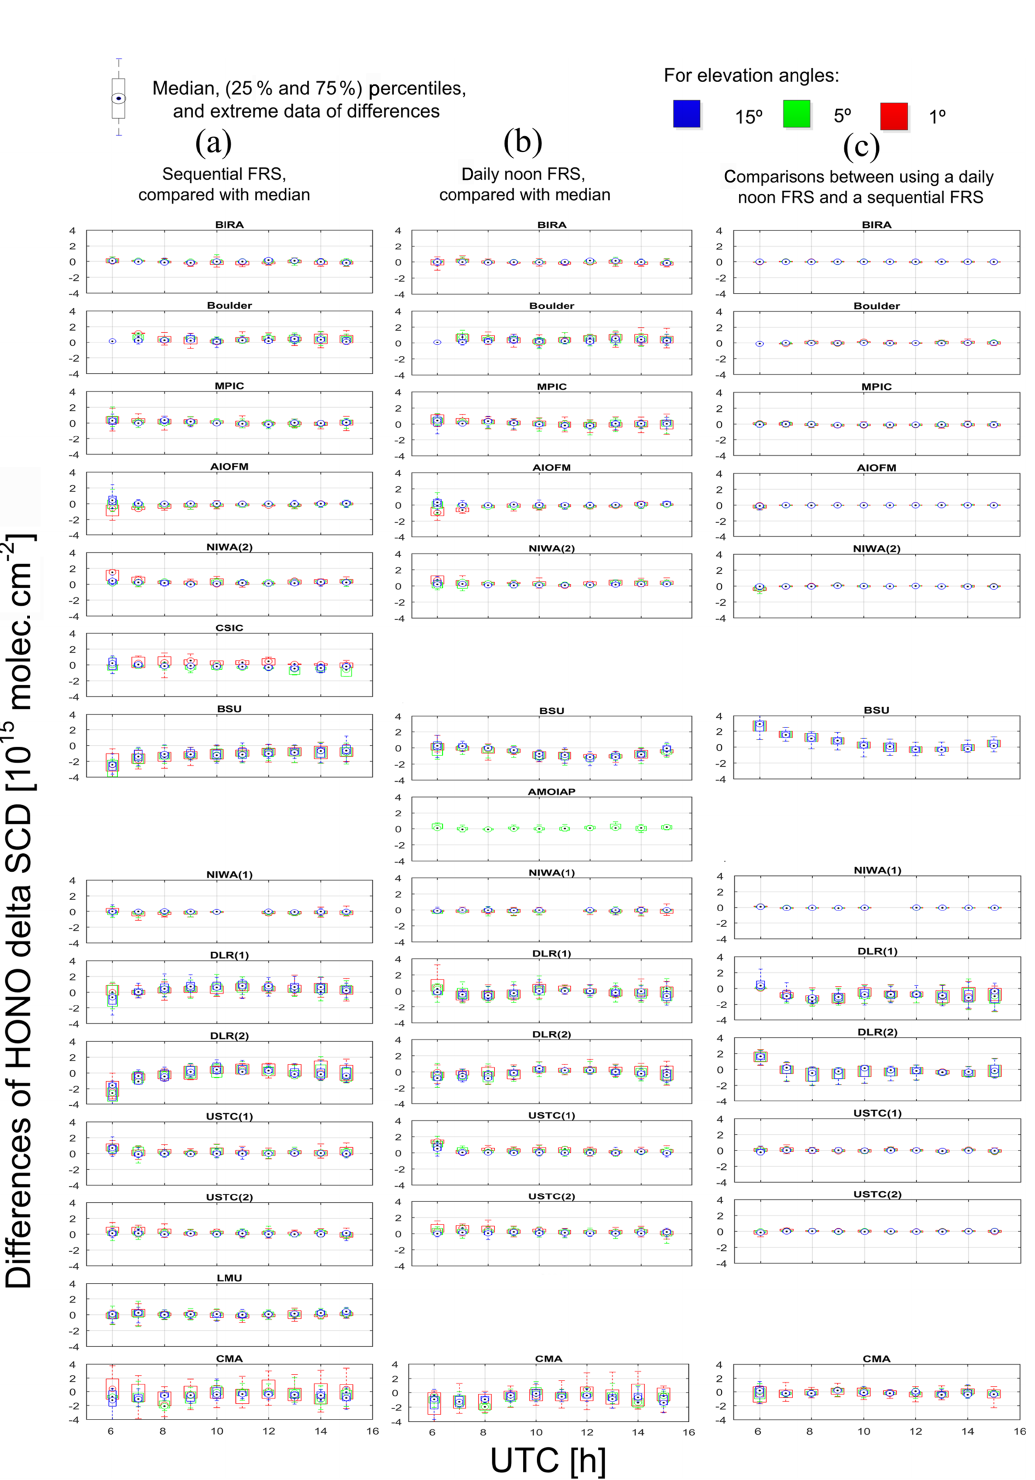
Figure 4. Boxplots (including median, percentiles, and extreme data) of the differences of the HONO delta SCDs for individual instruments (one instrument each row) with respect to the median values for the results using a “sequential FRS” (a) or a “daily noon FRS” (b) . In the (c) column of subplots, the differences of the HONO delta SCDs for the results using a “sequential FRS” or “daily noon FRS” are shown for the individual instruments. Colours indicate the elevation angles. The gaps between the subplots are due to unavailability of the corresponding